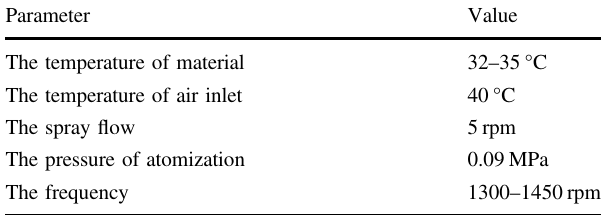
Table 5 The coating parameters of aspirin enteric pellets Parameter